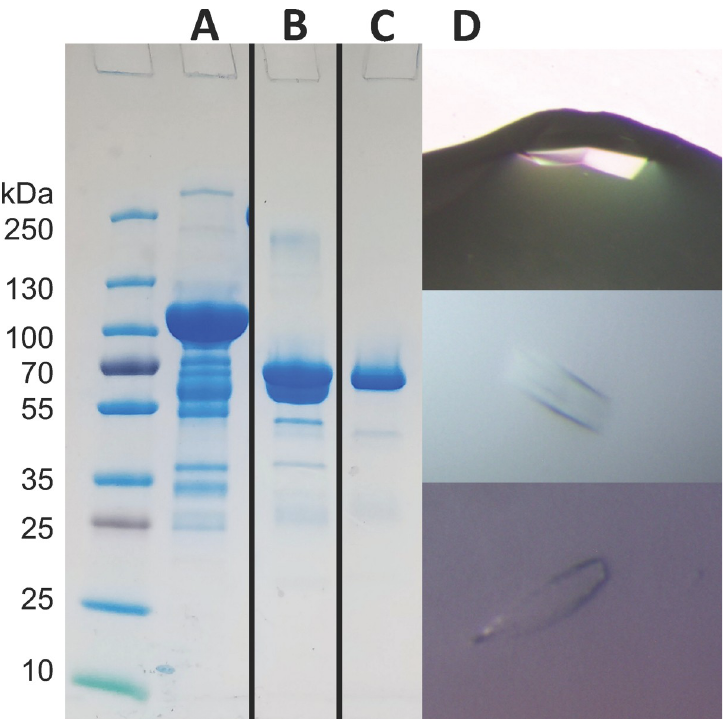
Fig 2. Purification and crystallization of EphB6-ECD. (A) EphB6-ECD-Fc after initial Protein A Sepharose purification; (B) EphB6-ECD upon addition of thrombin and Protein A Sepharose beads; (C) The finally purified EphB6-ECD, showing the expected molecular weight of ~65 kDa; (D) EphB6-ECD protein crystals.